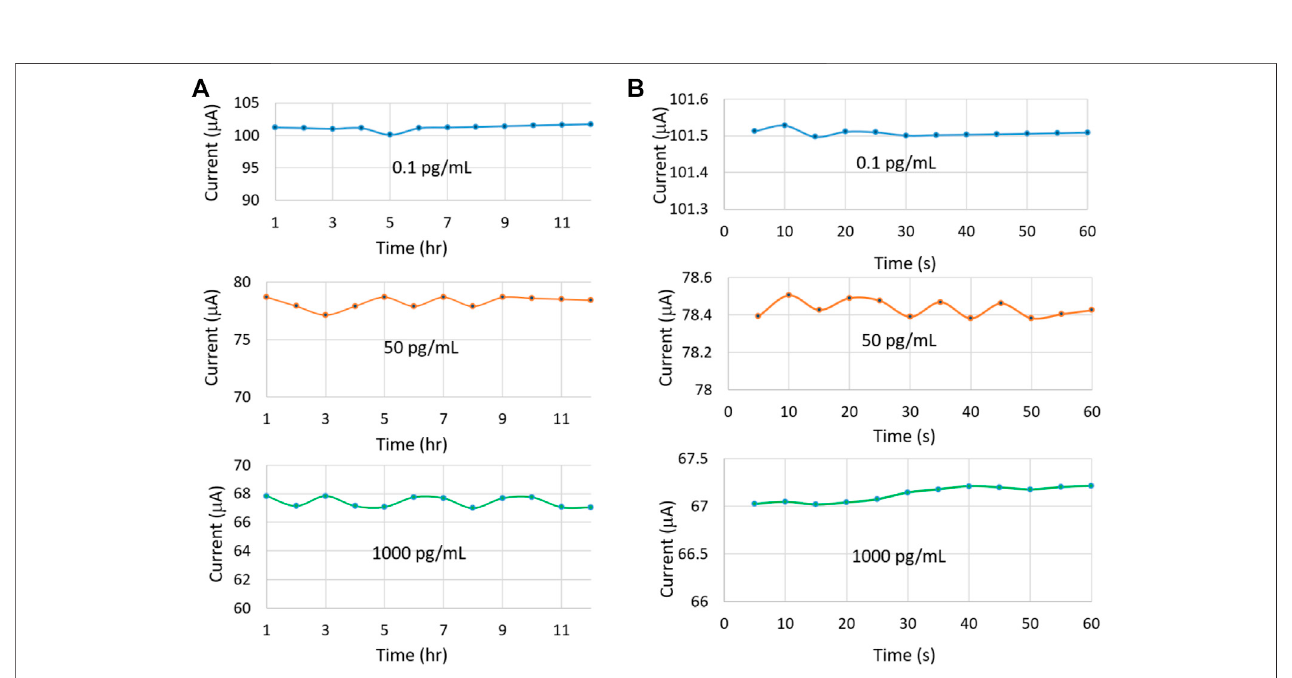
FIGURE 11 | Drift characteristics of the sensor for three different IL-10 concentrations over (A) 12 h and (B) 1 h.